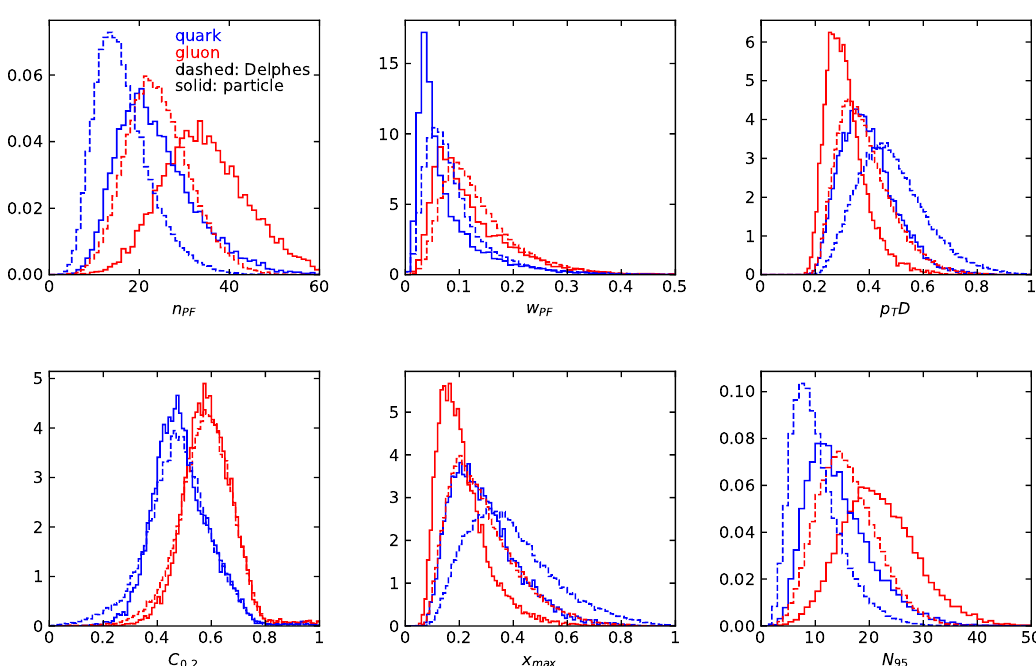
Figure 1: Normalized distributions for the subjet variables described in the text for pure quark and pure gluon jets, with and without detector effects. Jets are selected = 200 ... 220 with p T